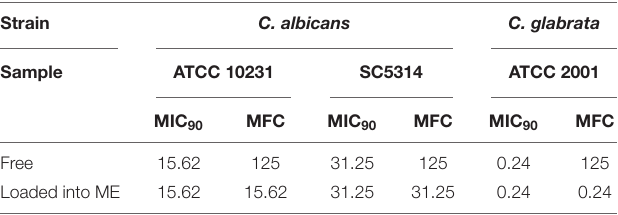
TABLE 1 | Inhibitory effect of free and loaded extract on C. albicans and C. glabrata planktonic cells.